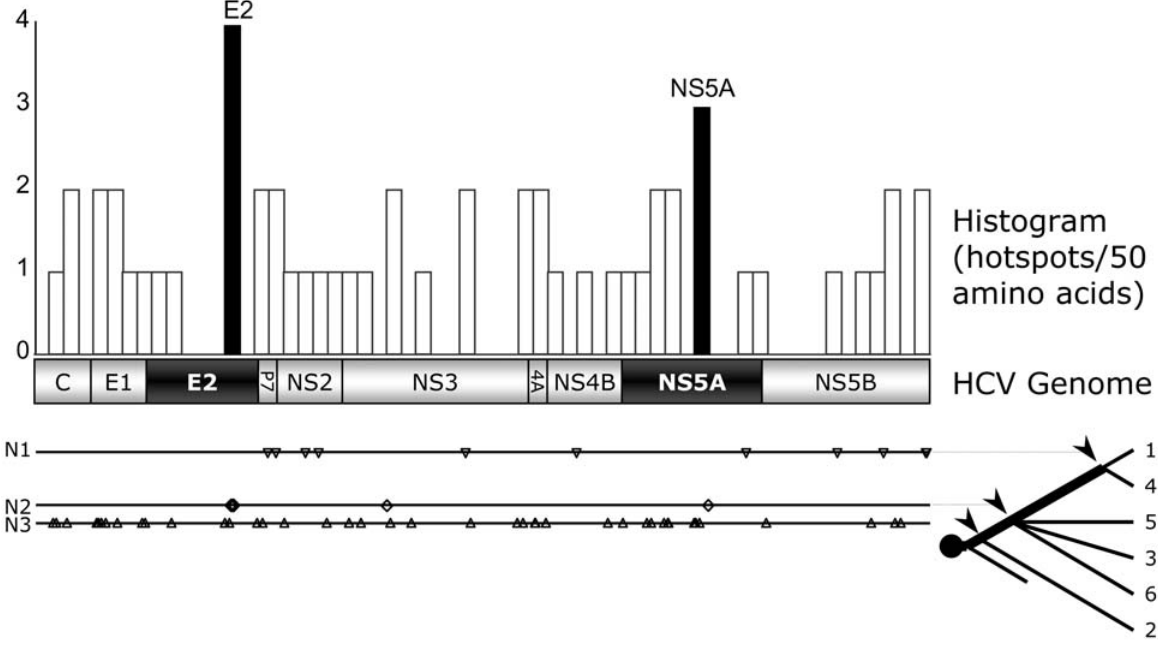
Figure 5. HCV Resistance Loci. Positions (‘‘hotspots’’) in the HCV genome that appear to have undergone directed change with respect to immune resistance. N1: positions associated, using ancestral sequence reconstruction techniques, with genotype (GN) 1 being the most resistant. N2: positions associated, using ancestral sequence reconstruction techniques, with GNs 1 and 4 being more resistant than GNs 2, 3, 5, and 6. N3: positions associated, using ancestral sequence reconstruction techniques, with GNs 1, 3, 4, 5, and 6 being more resistant than GN 2. A hotspot histogram (binned in groups of 50 amino acids) is shown at the top. The 10 proteins encoded by the HCV genome are also illustrated. Two loci were identified with the highest density of hotspots (black bars); these loci map to the PePHD domain of E2 and the PKR binding domain of NS5A, both of which have been shown to inhibit the innate immune factor PKR.